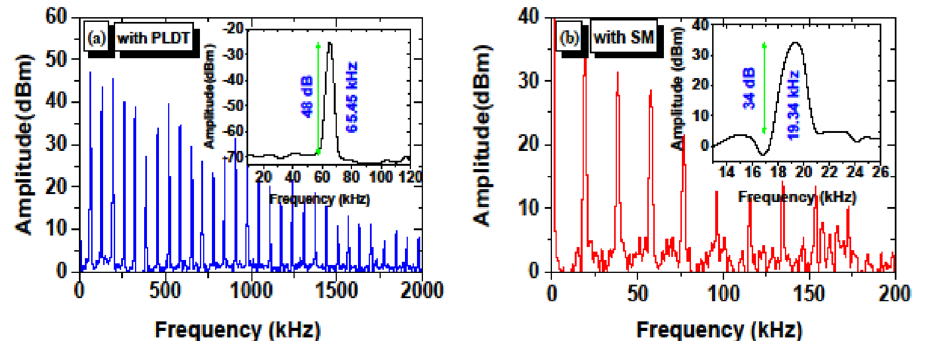
Figure 9. Measured RF spectra for SA prepared using ( a ) PLDT under frequency span 2 MHz, resolution bandwidth 1 kHz and video bandwidth 10 Hz and ( b ) SM technique under frequency span 200 kHz, resolution bandwidth 1 kHz and video bandwidth 10 Hz; inset shows SNR under pump power 45.7 mW.